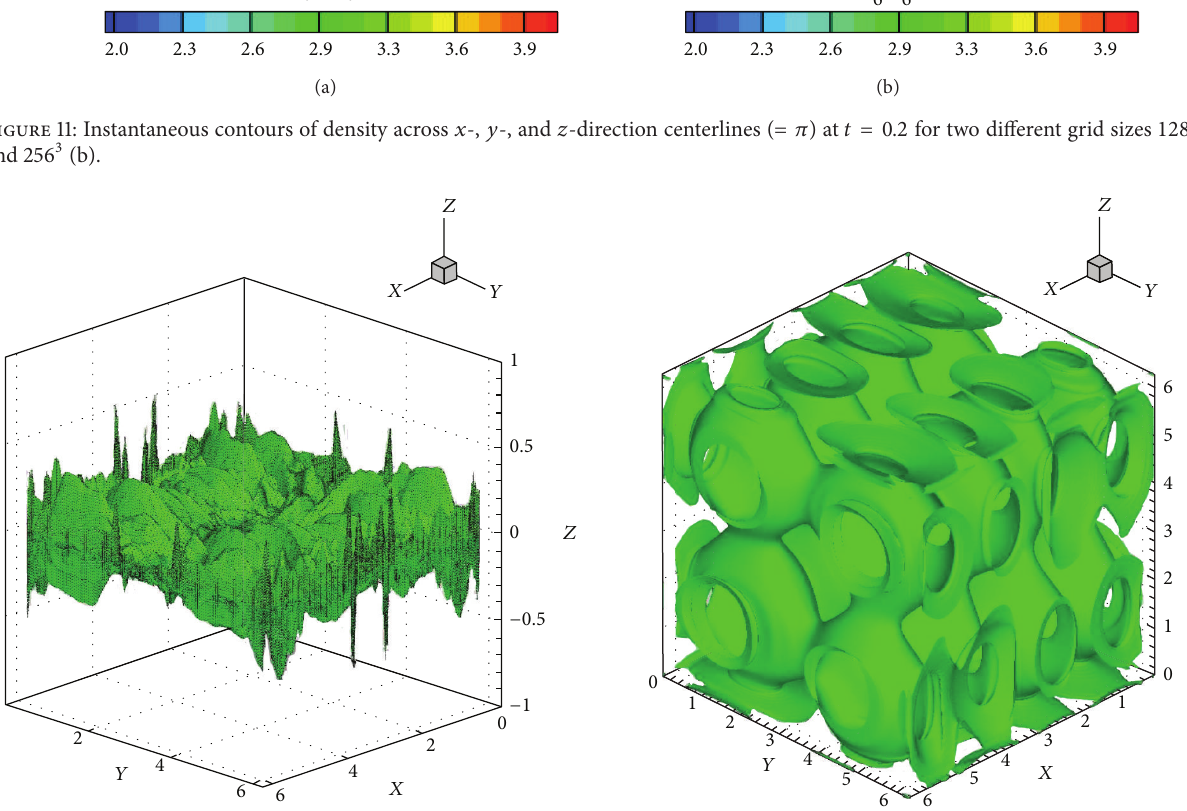
Figure 13: Isosurface of the density at a value 𝜌 𝐶 = 3.0 at 𝑡 = 0.2 . 2 := ‖ 𝜐 ‖ 2 is the velocity field with Euclidean norm 𝜐 , and , 𝐵 , 𝐵 ) 𝑇 and 𝐵 2 := ‖ B ‖ 2 represent the magnetic field B = (𝐵 1 2 3 and its norm, respectively. The pressure, 𝑝 , is coupled to the total internal energy, 𝐸 = (1/2)𝜌𝜐 2 + 𝑝/(𝛾 − 1) + (1/2)𝐵 2 . Furthermore, the system of MHD equations is augmented by the solenoidal constraint; that is, if the condition ∇ ⋅ B = 0 is satisfied initially at 𝑡 = 0 , then by (24) it remains invariant in